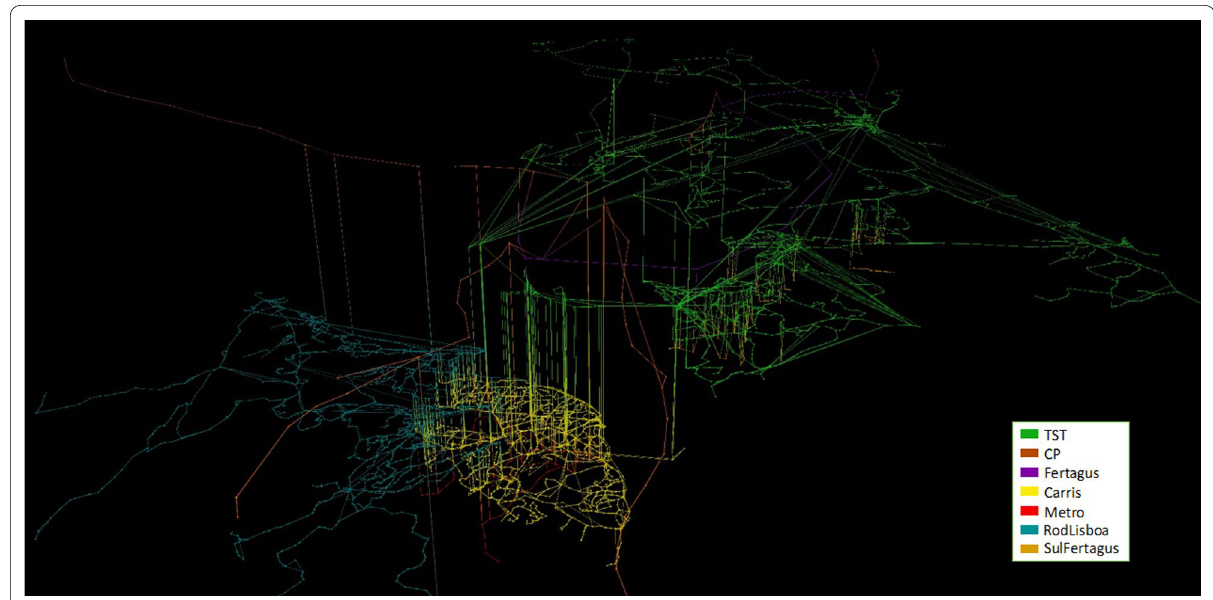
Fig. 5 Multilayer Lisbon transport network topology on a 3D representation with all the